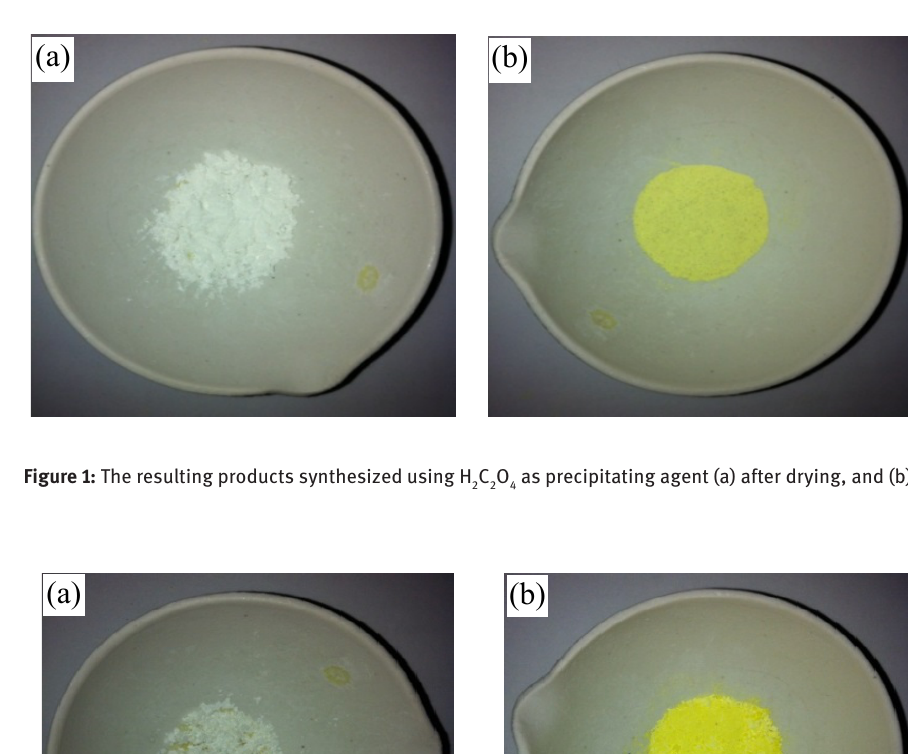
Figure 2: The resulting products synthesized using Na 2 CO 3 as precipitating agent (a) after drying, and (b) after calcination.